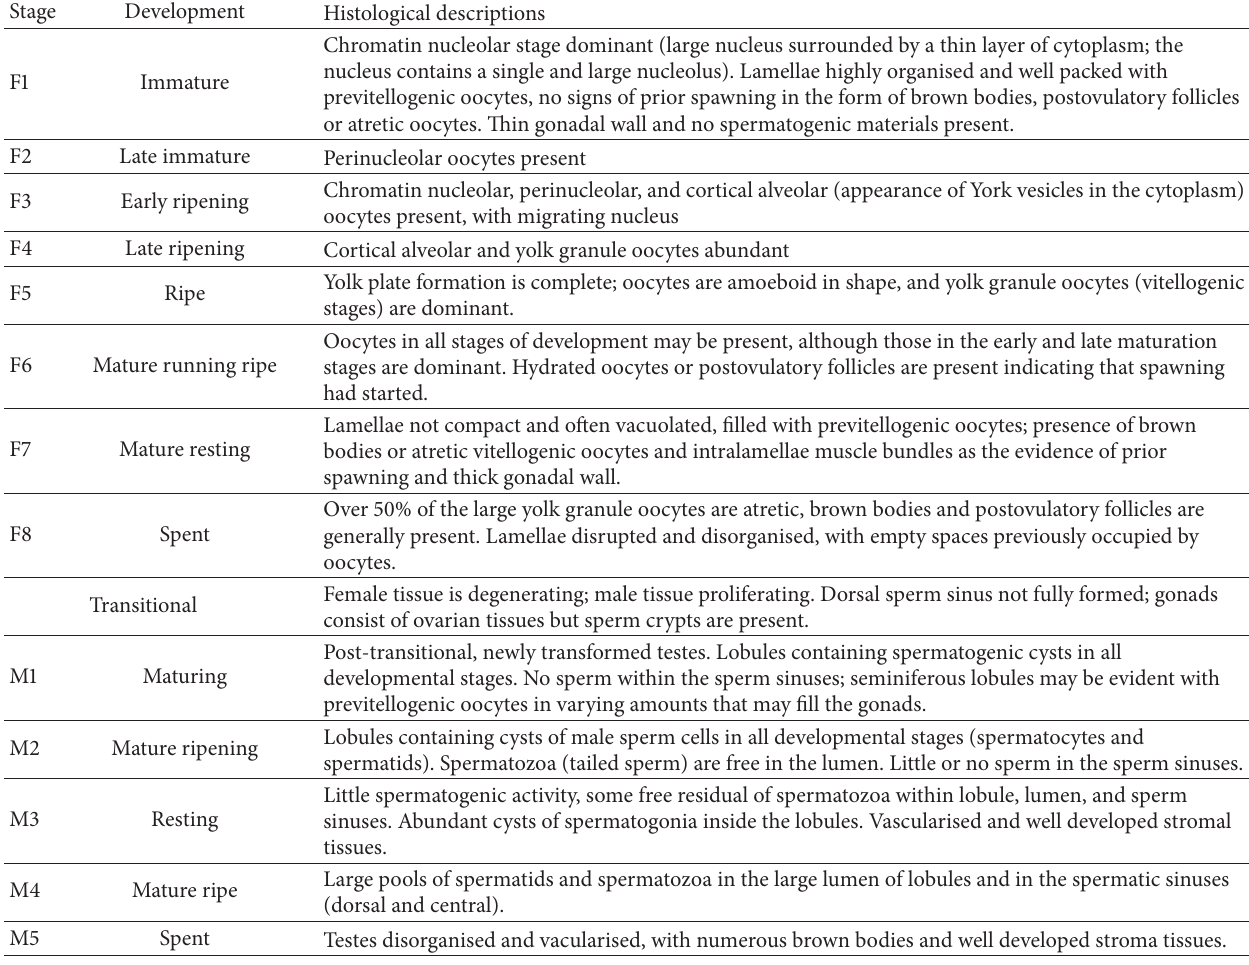
Table 1: Description of histological characteristics of various maturity stages of female (F) and male (M) gonads of Epinephelus malabaricus [1, 28–32]. Terminologies for oocyte stages are based on Wallace and Selman